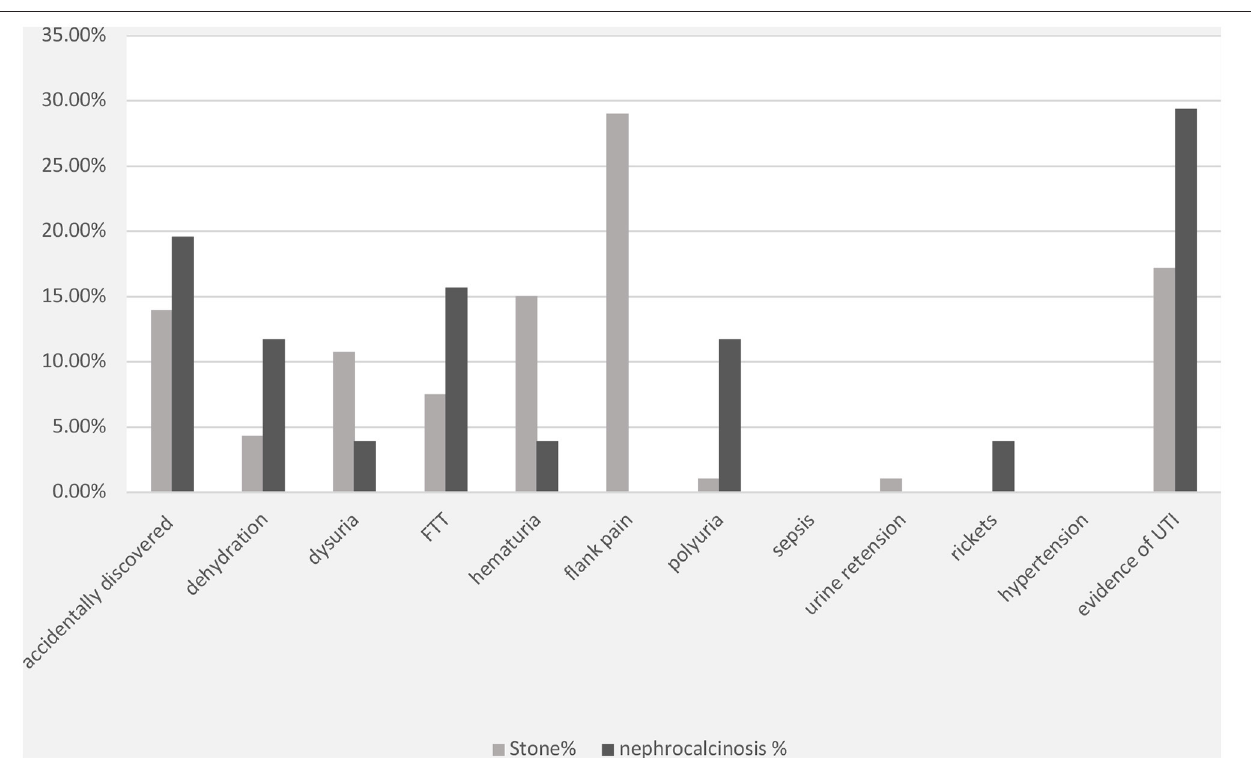
were reported in 28% of children with renal stones and in 9.8% of those with nephrocalcinosis ( Table 2